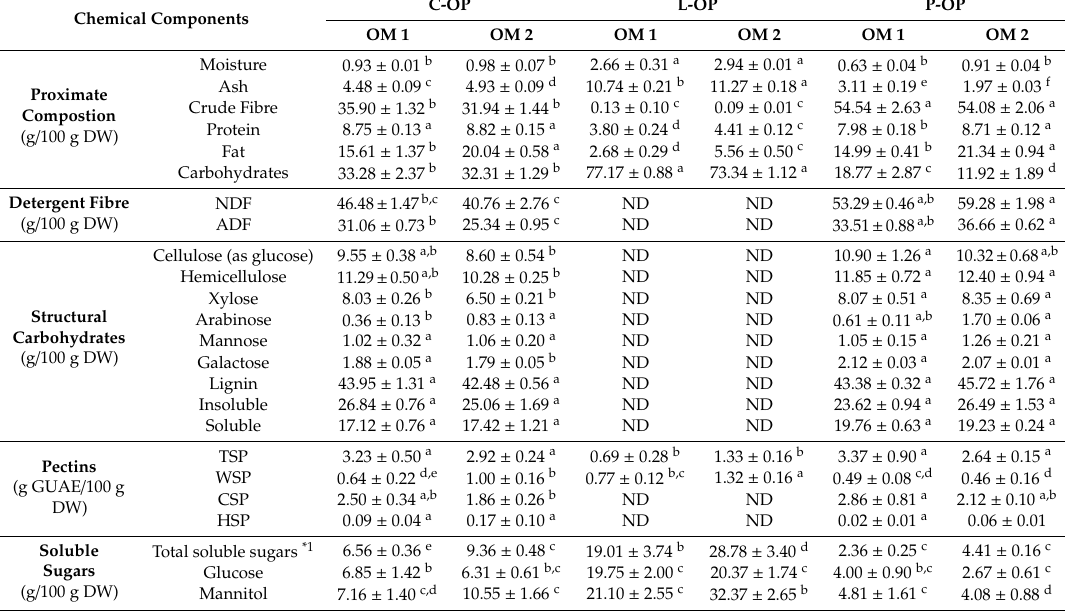
Table 1. Chemical composition of crude olive pomace (C-OP) and edible olive pomace fractions (L-OP and P-OP) produced after the wet and dry fractionation processes (g / 100 g DW (dry weight)). Chemical